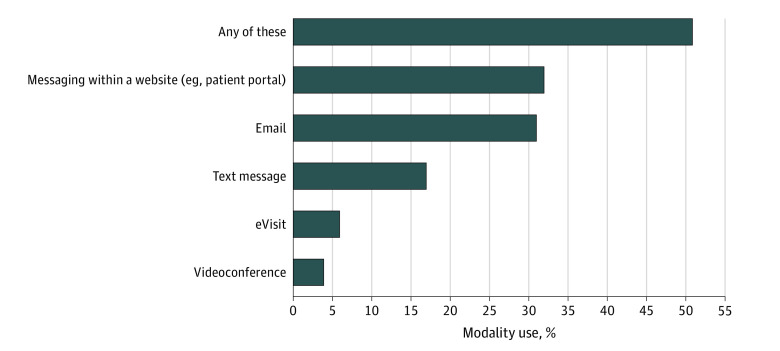
Proportion of Respondents Who Reported Ever Using Various Telehealth Modalities, WeightedMultiple choices could be selected; telephone visits were not included in this analysis. In this survey, an eVisit was described as “when you answer questions about your health issue online and hear back from a doctor later.”